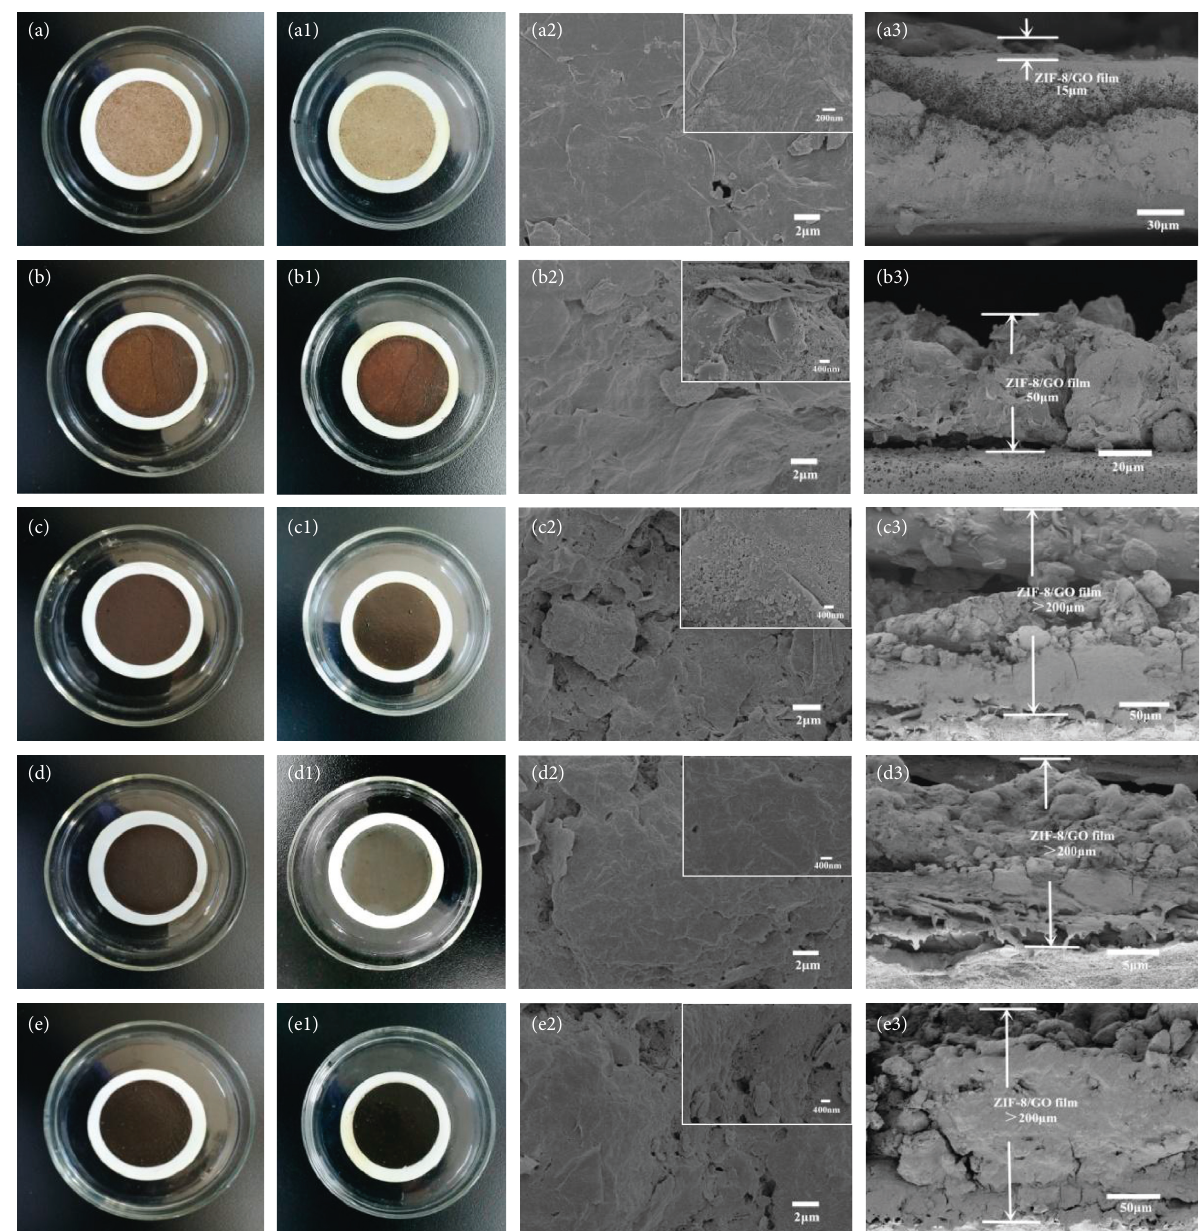
Figure 14: Photographs of (a)–(e) the ZIF-8/GO film with different thicknesses before adsorption tests and (a1)–(e1) ZIF-8/GO film with different thicknesses after adsorption tests. SEM image of (a2)–(e2) the surface and (a3)–(e3) the cross section of the ZIF-8/GO film with different thicknesses before adsorption